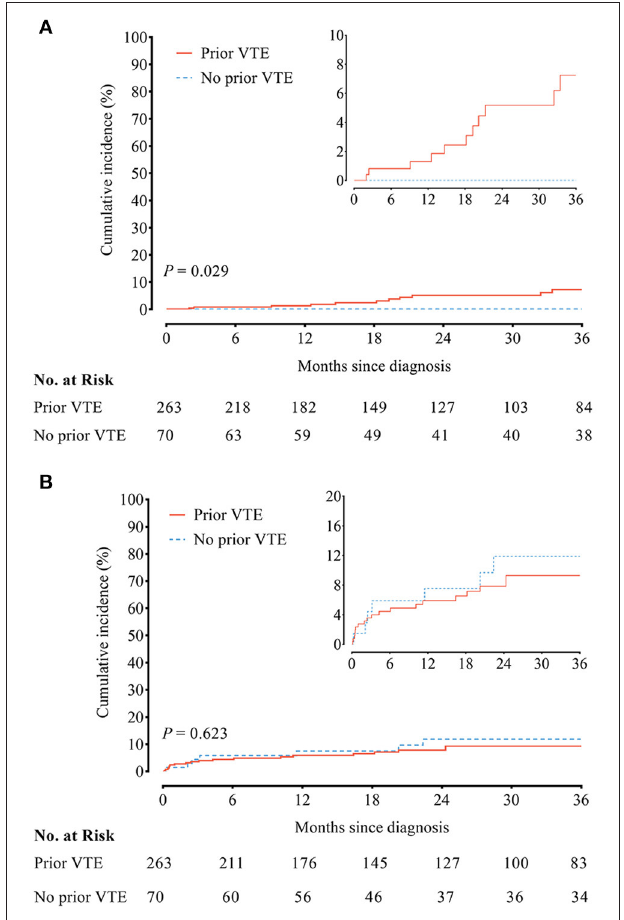
FIGURE 1 | (A) Recurrent venous thromboembolism (VTE) and (B) clinically relevant bleeding between chronic thromboembolic pulmonary hypertension (CTEPH) patients with and without a prior history of VTE.